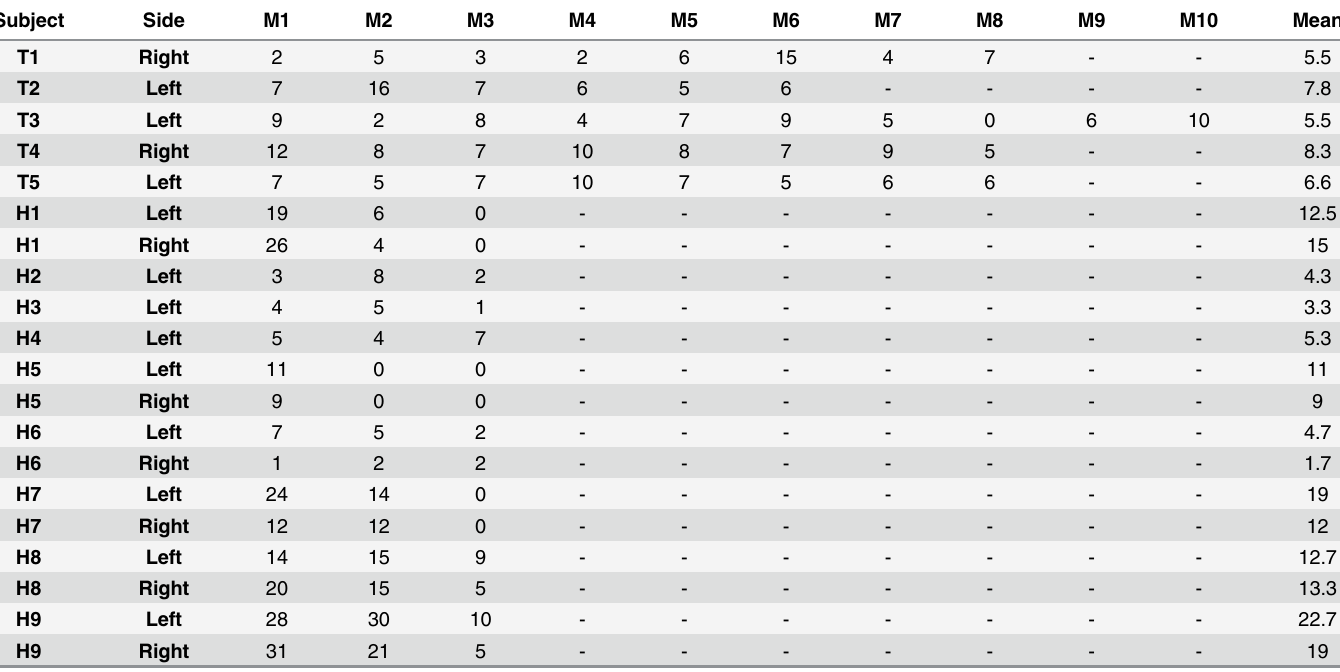
Table 2. Number of decomposed spike trains per movement for each subject.